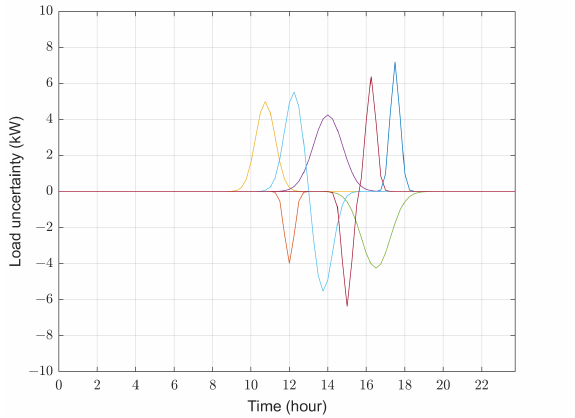
Figure 6. Load uncertainty data.